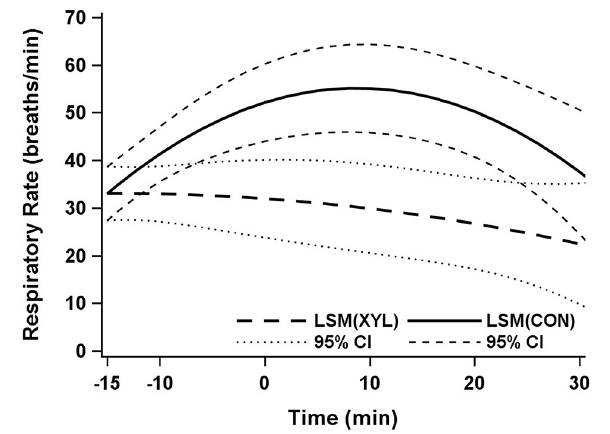
FIGURE 3 | Least Square Means (LSM) curves (polynomial regression) with 95% CI of the groups (XYL, CON) for the respiratory rate estimated with observations on 10 sheep ( n 5 per treatment). The sheep were placed in the = chute and the XYL group was injected with 0.1 mg/kg body mass xylazine hydrochloride ( 15min), brought into dorsal recumbency ( 10min), hoof − − trimmed (0min), tilted back (10min), left to stand in the chute (20min), and brought back to their box